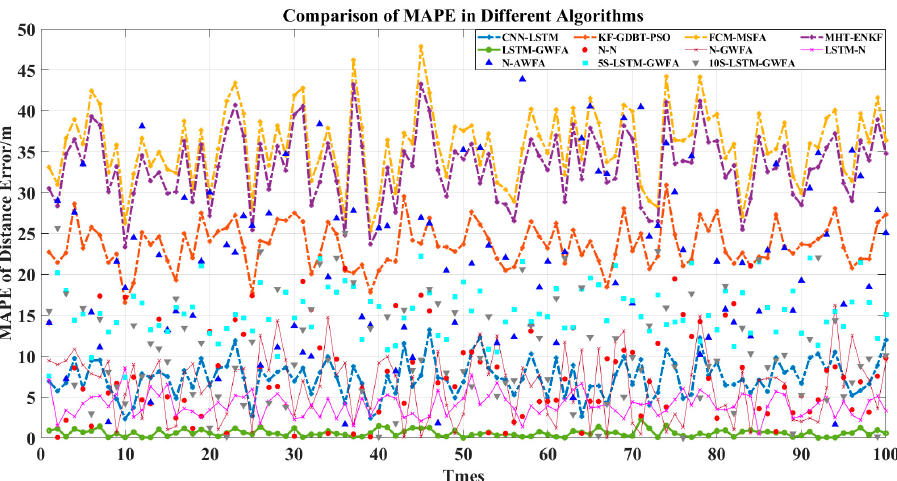
Figure 5. Comparison of MAPE with 100 tracks in different algorithms.